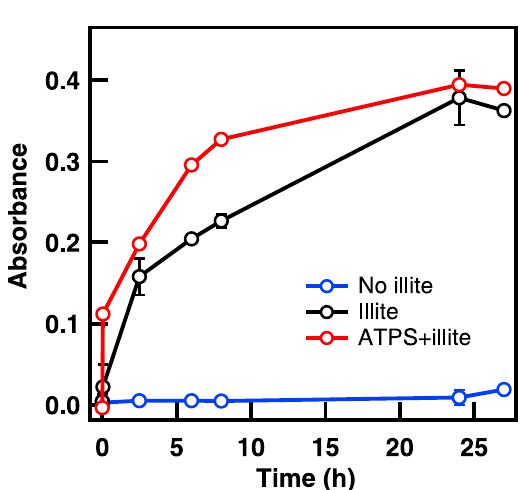
Figure 7. Darkfield optical microscope images showing ATPS before ( A , B ) and after ( C , D ) addition of clay microparticles. Kaolinite-stabilized PEG-rich droplets in Dx-rich continuous phase ( C ) (phase volume ratio 1:20 PEG-rich: Dx-rich), illite-stabilized Dx-rich droplets in PEG-rich continuous phase ( D ) (phase volume ratio 20:1 PEG-rich: Dx-rich) are formed. All scale bars represent 20 µ m. Stock ATPS for both samples was 15%/15% w/w PEG 8 kDa-Dx 10 kDa.